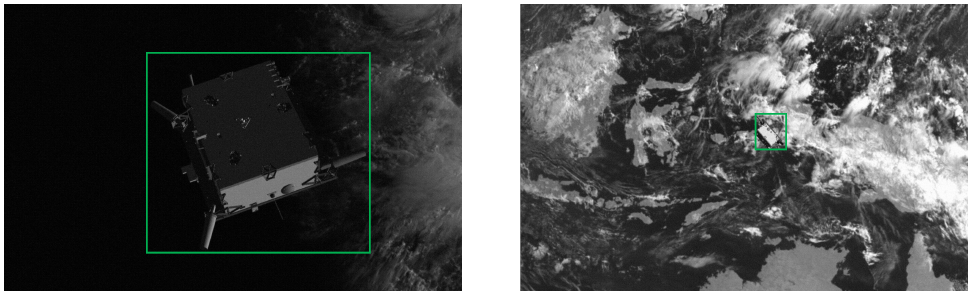
Figure 5. Large variation of the space target size in the SPEED